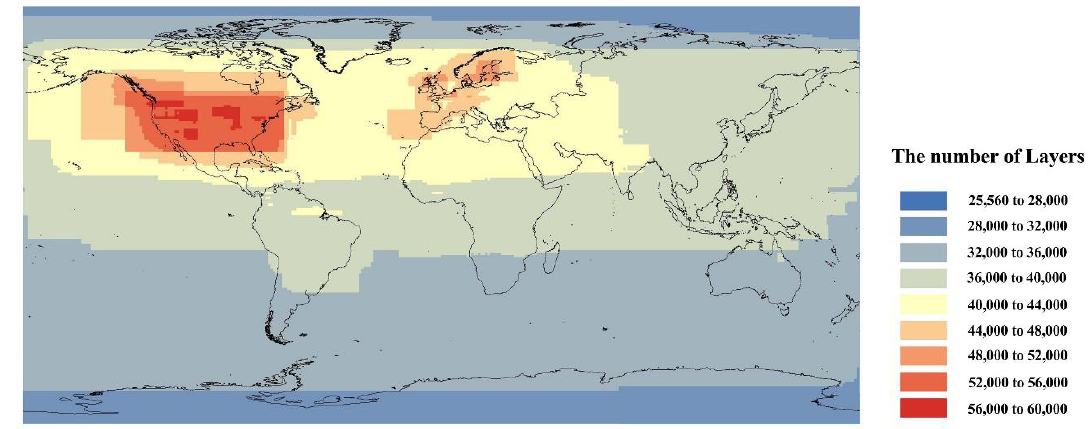
Figure 9. The spatial coverages of Map Layers.